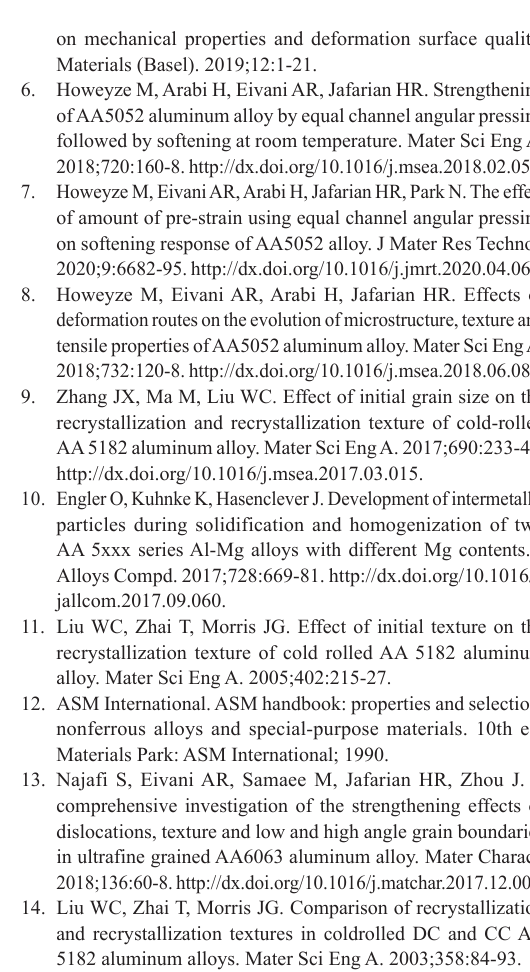
Figure 9. AA 5182 aluminum alloy heated for a period of 10 min. SEM-EDS of the fractures in samples annealed at a) 50 °C and b) 100